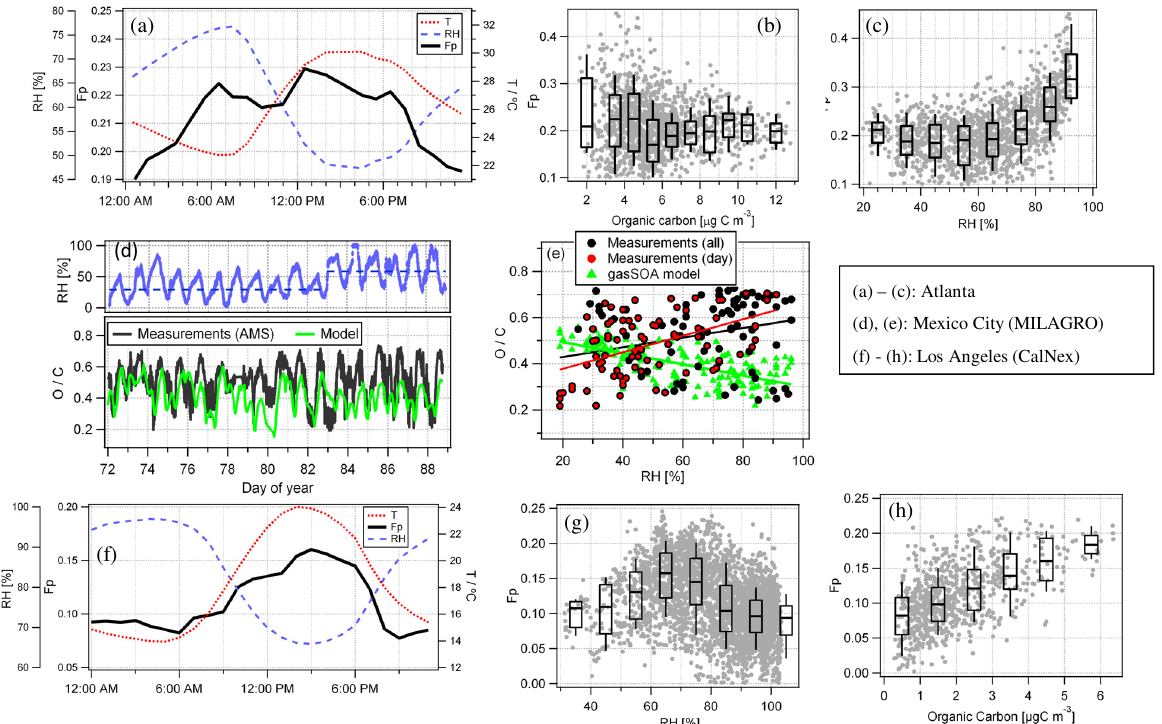
Fig. 2. Observations of organic carbon or related parameters at different locations. Upper panel: Atlanta: (a) averaged diurnal evolution of temperature, RH and WSOC fraction in the particle phase ( F p ); (b) F p as a function of RH; (c) F p as a function of total organic carbon Middle panel: Mexico City: (d) temporal evolution of RH and O/C ratio (AMS data and model prediction; Hodzic et al., 2010); (e) observed and predicted O/C ratio as a function of RH; black symbols show all data points; red symbols show only data recorded during day time (06:00a.m.-06:00p.m.). Bottom panel: Los Angeles: (f) averaged diurnal evolution of temperature, RH and WSOC fraction in the particle phase ( F p ); (g) F p as a function of RH; (h) F p as a function of total organic